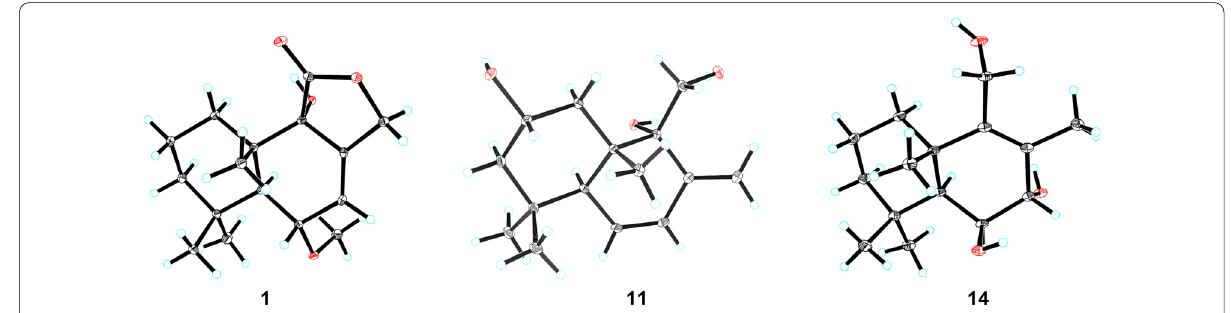
Fig. 4 X-ray crystallographic structures of 1 , 11 , and 14